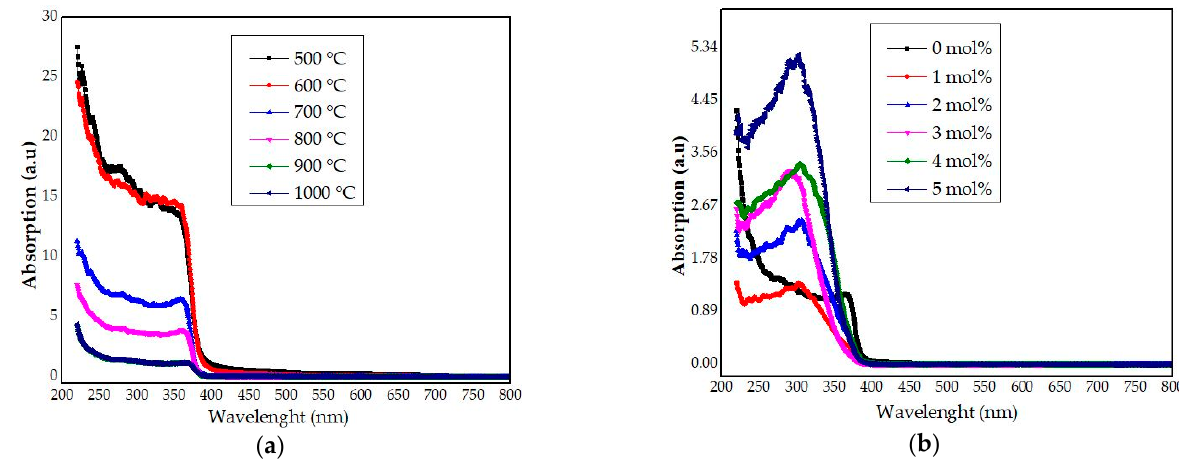
Figure 14. UV absorption spectra of ( a ) willemite NPs calcined at different temperatures, and ( b ) willemite doped with different Ce 3+ concentrations calcined at 900 °C.